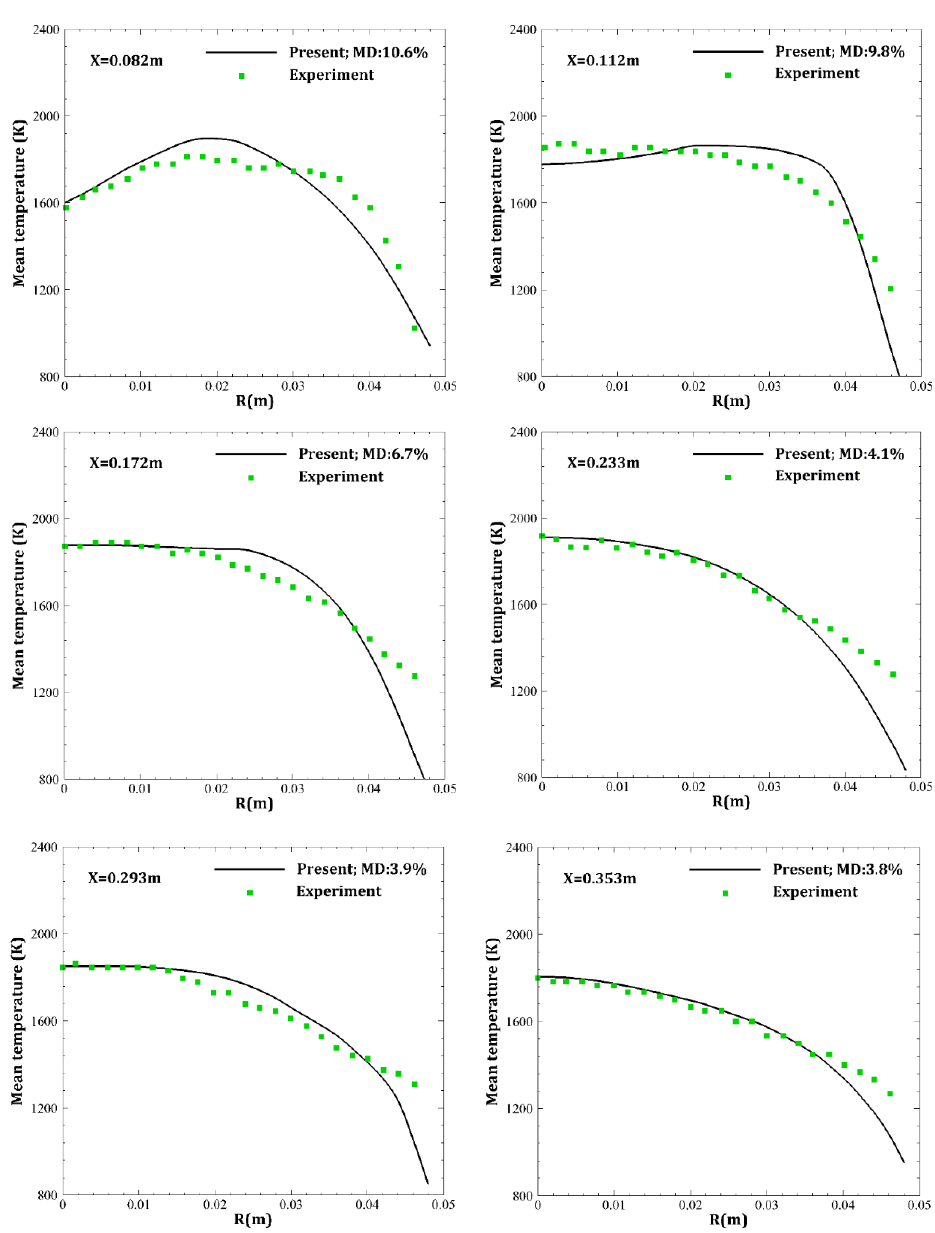
Figure 7. Present lateral profiles of mean temperature as compared with experimental data [1], at different positions.